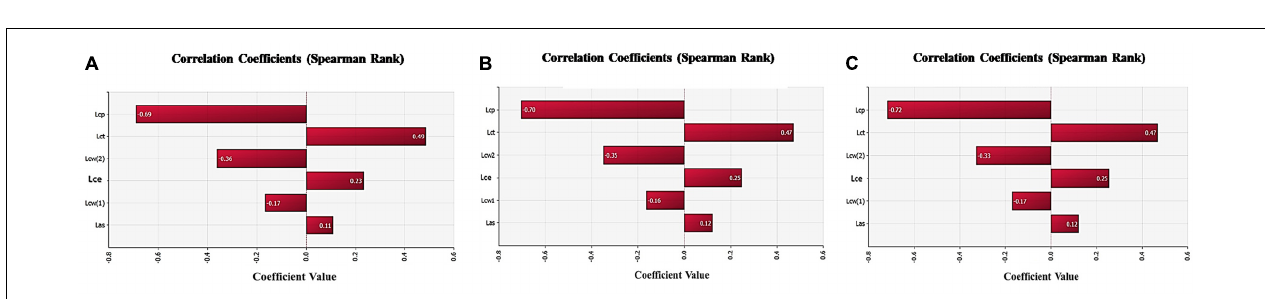
FIGURE 4 | Sensitivity analysis of each slaughtering processes in the model. (A) Sensitivity analysis of each slaughtering process in all swine slaughterhouses. (B) Sensitivity analysis of each slaughtering process in small swine slaughterhouses. (C) Sensitivity analysis of each slaughtering process in big